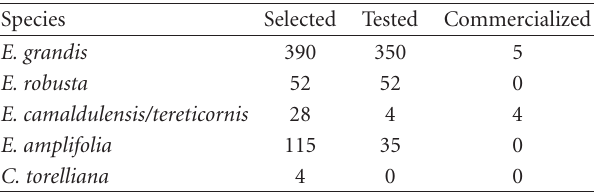
Table 2: Numbers of clones selected, tested, and commercialized by species. Species Selected Tested